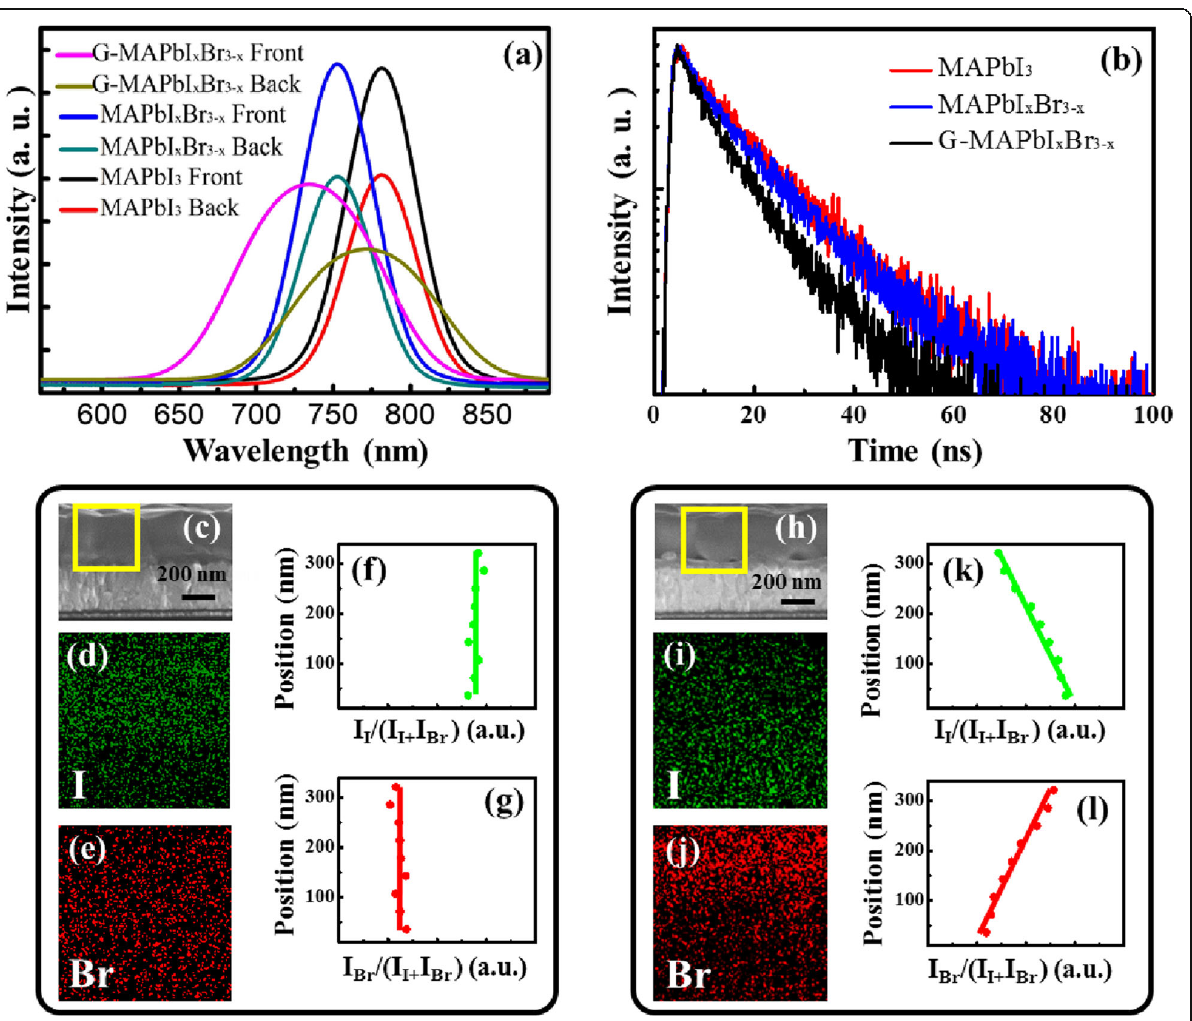
Fig. 5 a Steady-state PL spectra. b TRPL spectra. c Cross-section image of an MAPbI x Br 3 − x film. d , e EDS mapping images of I and Br elements in the area marked in ( c ), respectively. f , g Relative intensity of I and Br element based on ( d ) and ( e ) images along the longitudinal direction. h Cross-sectional image of a G-MAPbI x Br 3 − x film. i , j EDS mapping images of I and Br elements in the area marked in ( h ), respectively. k , l Relative intensity of I and Br element based on ( i ) and ( j ) images along the longitudinal